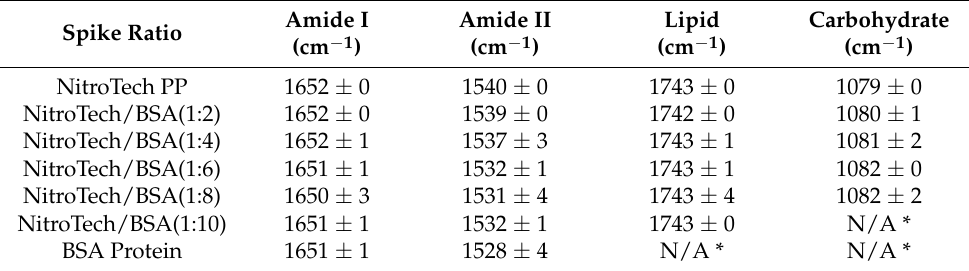
Table 5. IR data of whey protein powder NitroTech, spiked with a known amount of a single whey protein, bovine serum albumin